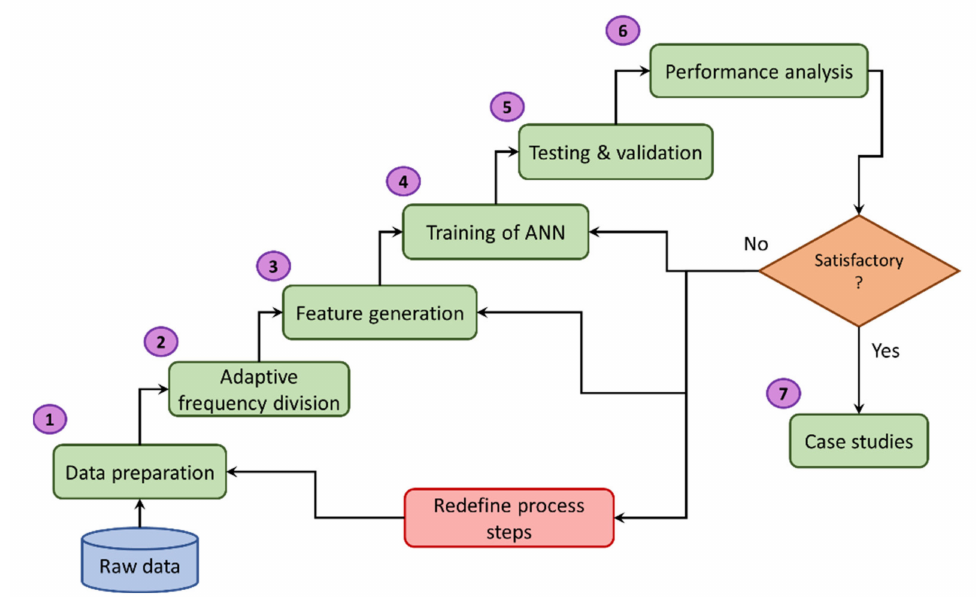
Figure 1. Flowchart for intelligent fault detection